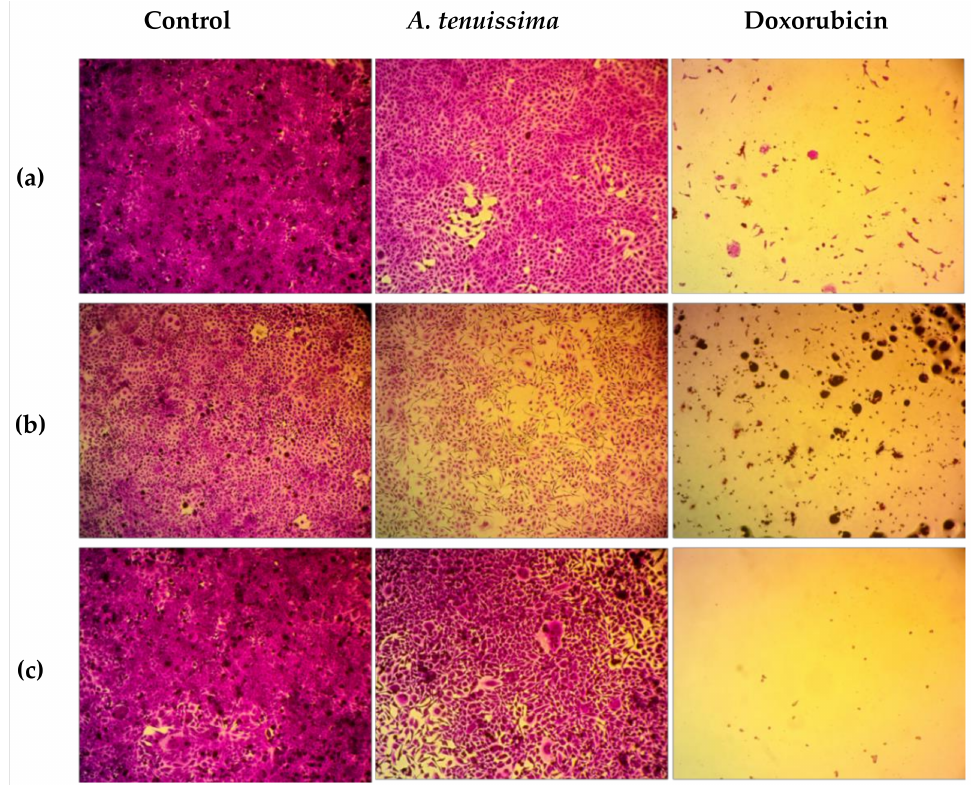
Figure 2. Optical microscope images of cytotoxicity assay A. tenuissima extract and doxorubicin (100 µ g/mL) on HeLa cells ( a ), SKOV-3 ( b ), and MCF-7 ( c ), magnification power: X100.